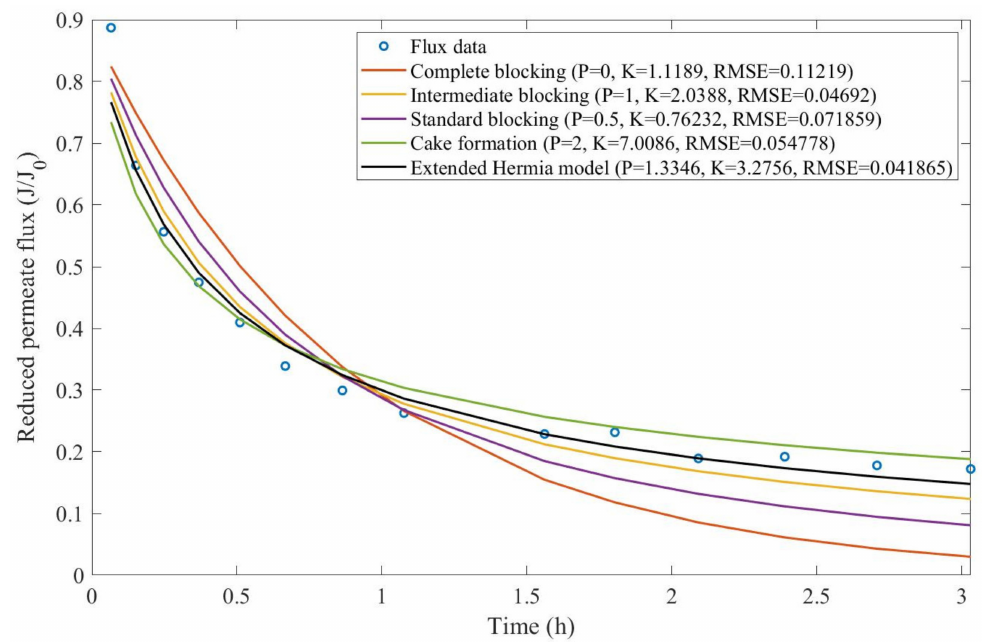
Figure A30. Model fitting for the first fouling stage of ultrafiltration of bovine serum albumin solution at 103.421 kPa considering the four original pore-blocking mechanisms and the extended Hermia model (Uncoated membrane) (29).